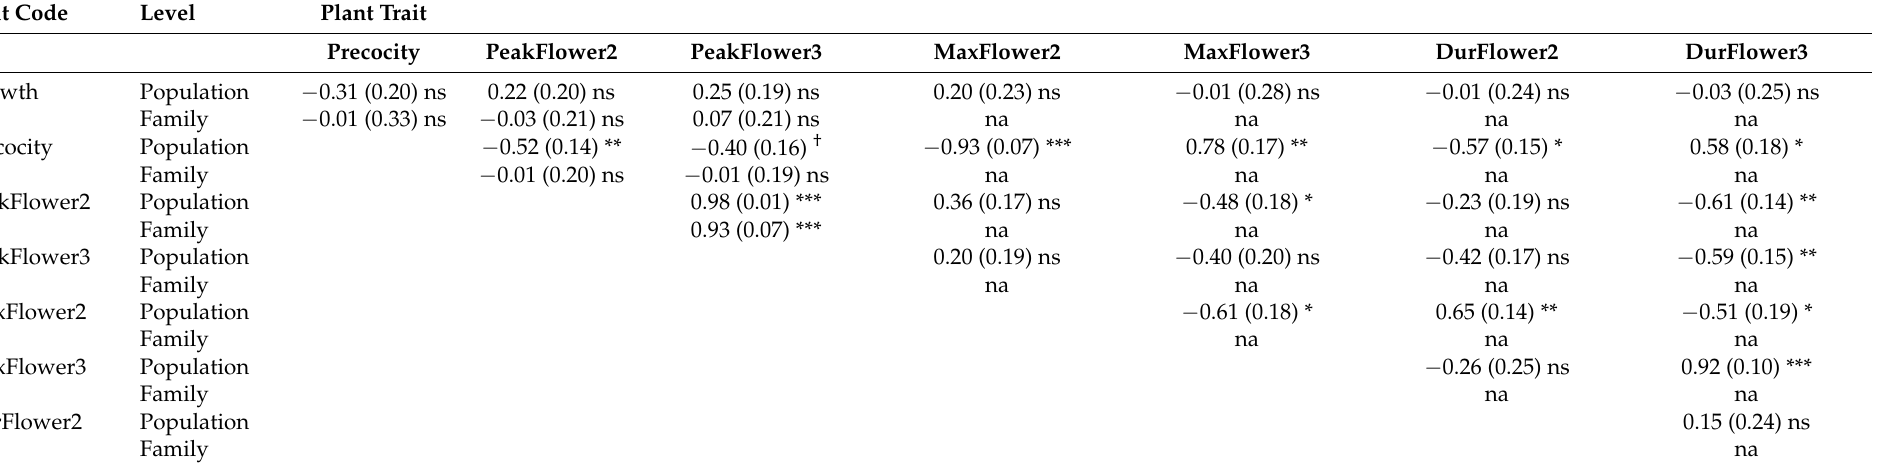
Table 3. Population level and family-level genetic correlation and standard error between Leptospermum scoparium traits. Trait codes are provided in Table 1. Correlation results were only calculated where both traits showed significant variation at the level presented (population or family) in the univariate